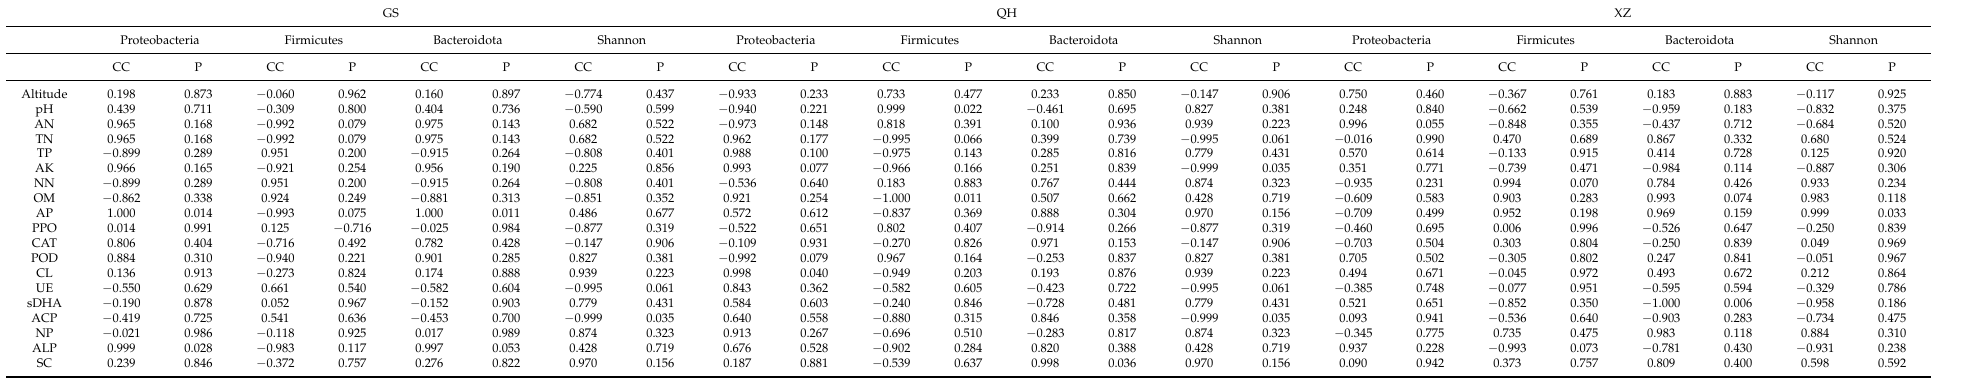
Table A2. Pearson correlation analysis of S. purpurea bacteria